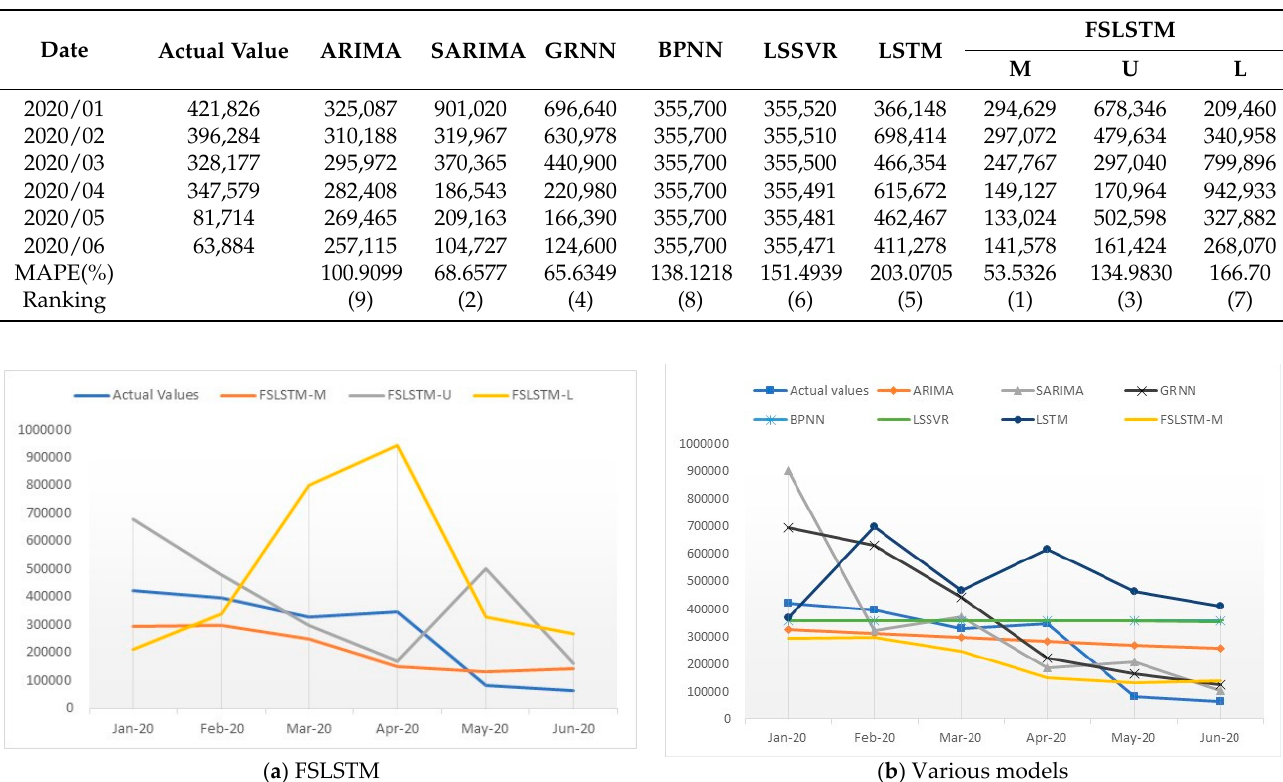
Figure 6. Illustration of the actual and forecasting power outputs of various models for the Taichung wind power plant.